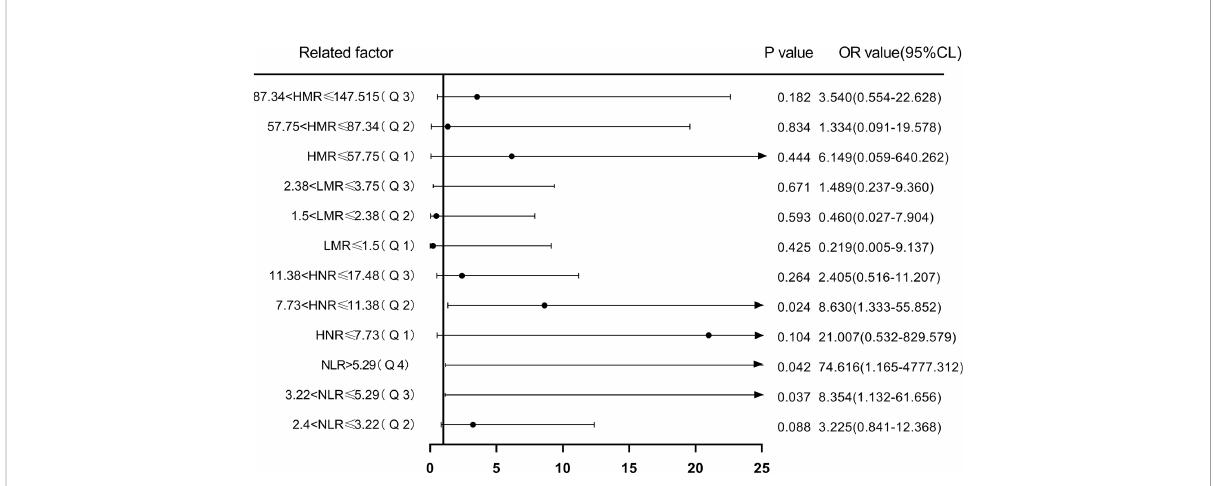
FIGURE 8 Forest plot of multifactorial logistic regression analysis of NLR, LMR, HNR, and HMR (four groups of classi fi cation) in predicting NSCLC metastasis. (Note: multifactor correction included variables ANC, ALC, AMC, HDL).